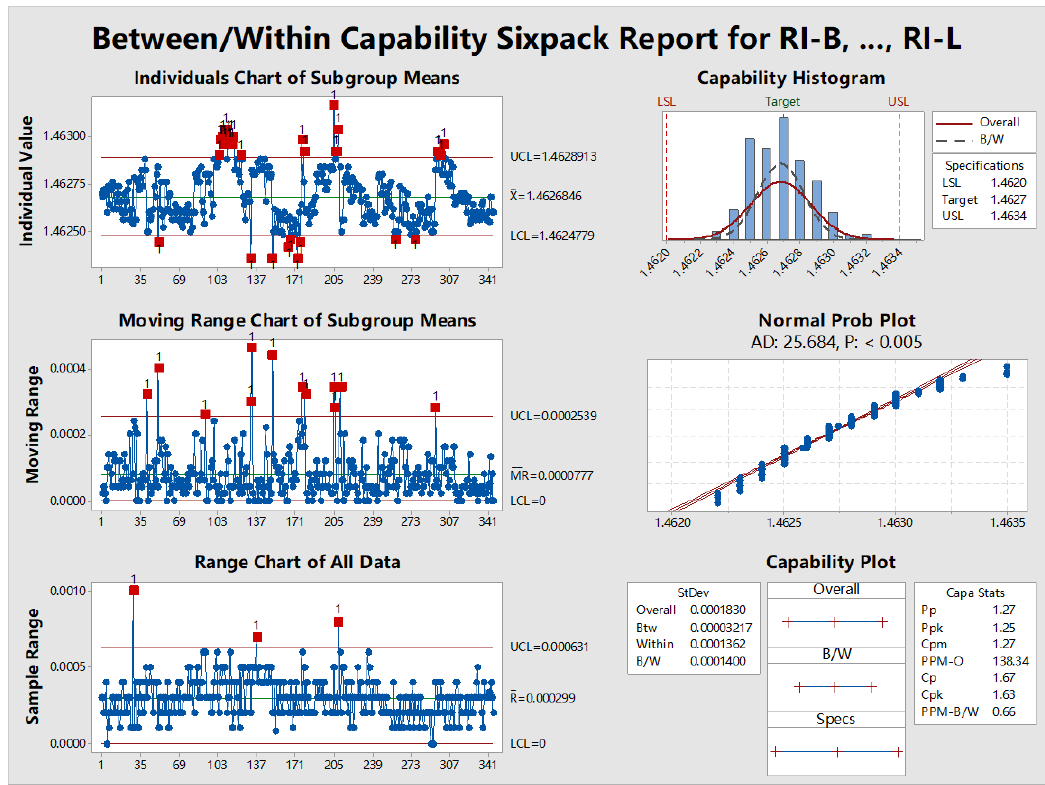
Figure 3. RI between/within capability sixpack report results for the 345 wafers.